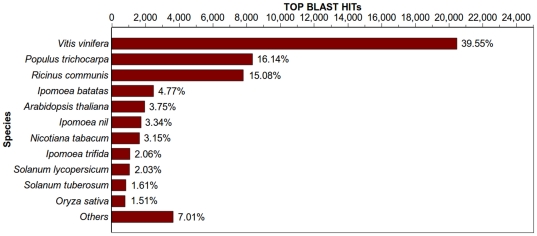
Top-Hit species distribution.51,763 BLASTX-hit transcripts were calculated. Species with proportions of more than 1% are shown. More than 70% of the identified transcripts have the highest homology with Vitis, Populus or Ricinus. Less than 5% of the top matches hit sweet potato itself due to the limited number of the sweet potato protein sequences available in the NCBI database.